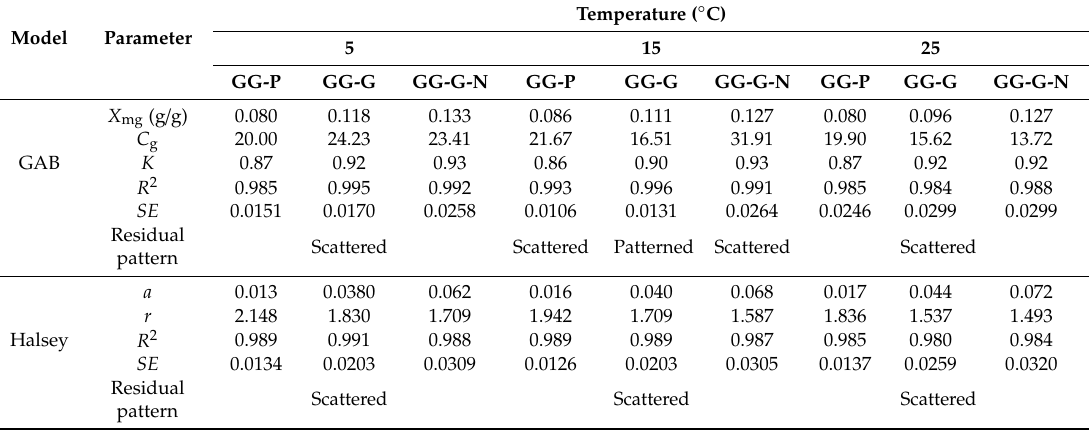
Figure 1. Moisture sorption isotherms of gum ghatti (GG)-based films at di ff erent temperatures; ( a ) GG-P, ( b ) GG-G, ( c ) GG-G-N, and ( d ) temperature of 25 ◦ C. GG-P, pure gum ghatti film; GG-G, gum ghatti film with incorporation of glycerol; GG-G-N, gum ghatti film with incorporation of glycerol and nisin. Table 2. Estimated parameters of the selected models fitted to sorption data of GG-based films at di ff erent